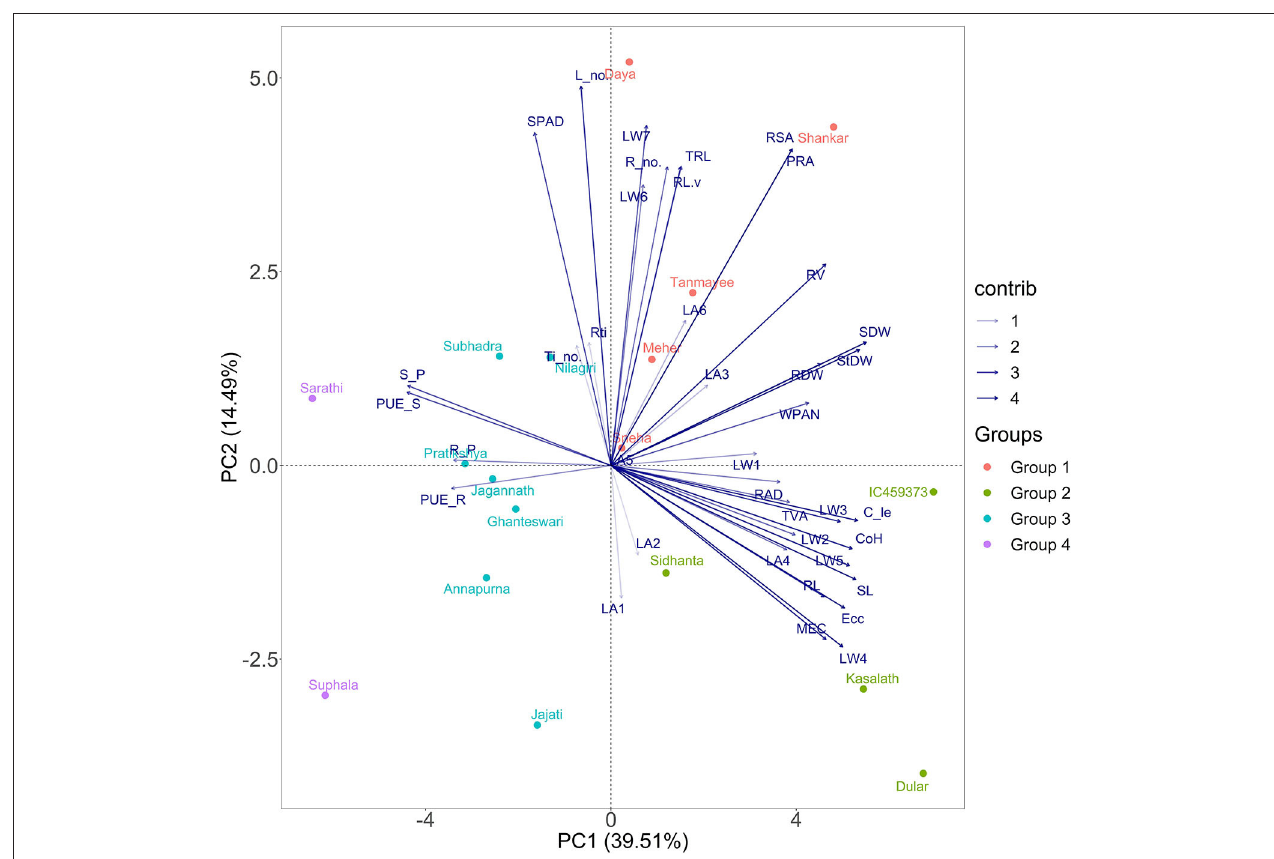
FIGURE 3 | Principal component analysis (PCA) biplot of the 18 genotypes based on variance in 38 morpho-physiological and geometric traits measured in P stress environment, explained by two axes. Together, the two PC axes explained 54% of the total variance. The transparency of the vector indicates the contribution to the variance in the dataset, ranging from 1 (lightest) to 4% (darkest). The direction and length of the vector represent trait contribution to the first two components of the PCA. Genotypes are grouped into four based on their expression pattern of morpho-physiological and geometric traits measured under deficient P conditions. Group 1 (orange circle) shares high values of root surface area, Group 2 (green circle) shares high values of leaf area and weight, and Group 3 (cyan colour) and Group 4 (purple colour) share high values of the shoot and root P content with reduced